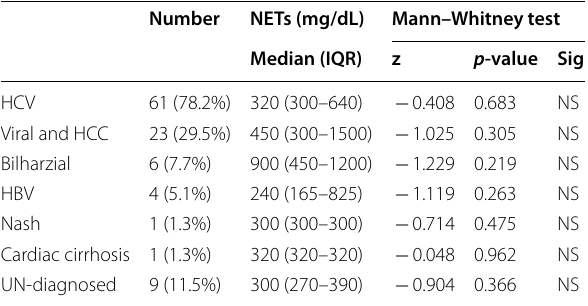
Table 1 Etiology of chronic disease for the study group Etiology